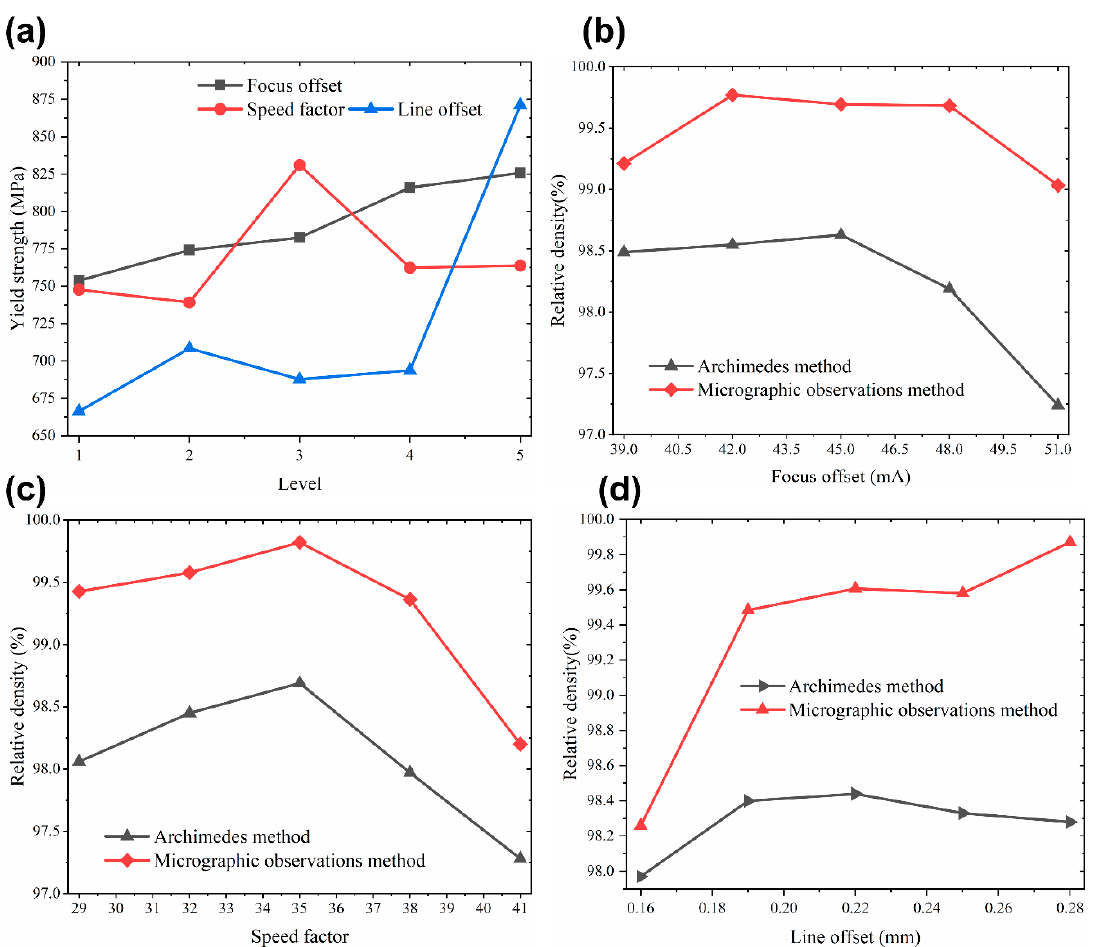
Figure 8. ( a ) Effect of various process parameters on the yield strength of EBM Ti-6Al-4V specimens; Figure8. ( a )E ff ectofvariousprocessparametersontheyieldstrengthofEBMTi-6Al-4Vspecimens; ( b – d ) ( b – d ) effect of focus offset ( b ), speed factor( c ), line offset ( d ) on relative density of EBM Ti-6Al-4V e ff ect of focus o ff set ( b ), speed factor( c ), line o ff set ( d ) on relative density of EBM Ti-6Al-4V specimens.